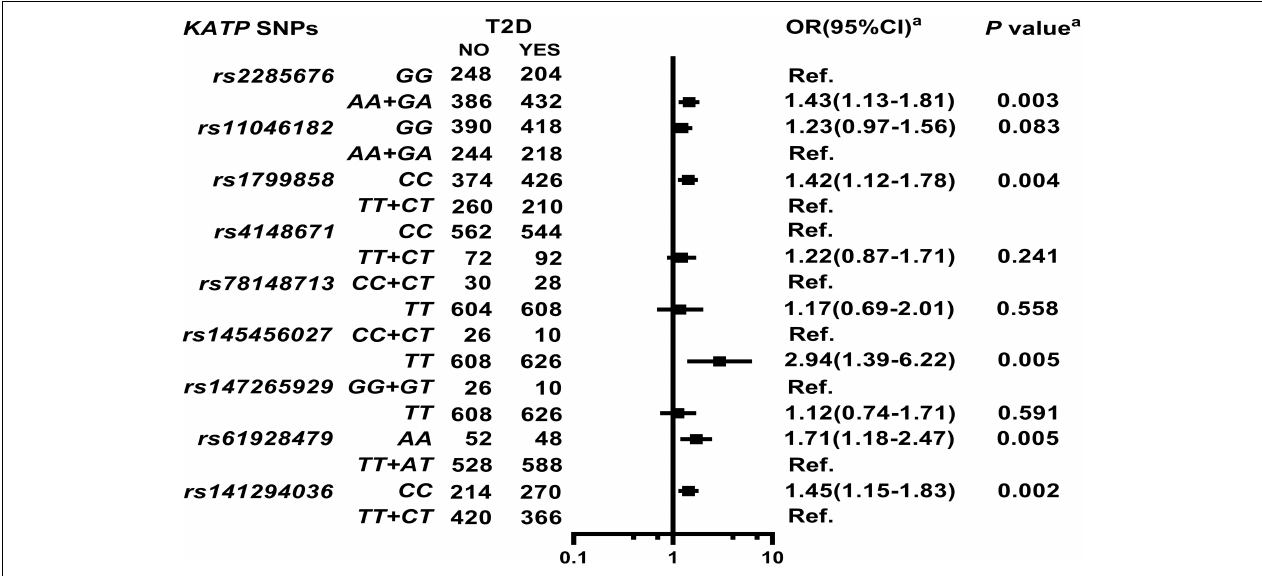
FIGURE 1 | Association of ATP-sensitive potassium channels ( KATP ) single nucleotide polymorphisms (SNPs) with Type 2 diabetes (T2D) in the study participants. a Model: After adjustment for gender, age, smoking, alcohol consumption, body mass index (BMI), systolic blood pressure (SBP), diastolic blood pressure (DBP), high-sensitivity C-reactive protein (HsCRP), and renin-angiotensin-aldosterone system (RAAS activity) [angiotensin converting enzyme (ACE), renin, angiotensin I (Ang I), angiotensin II (Ang II), and aldosterone (ALD)].